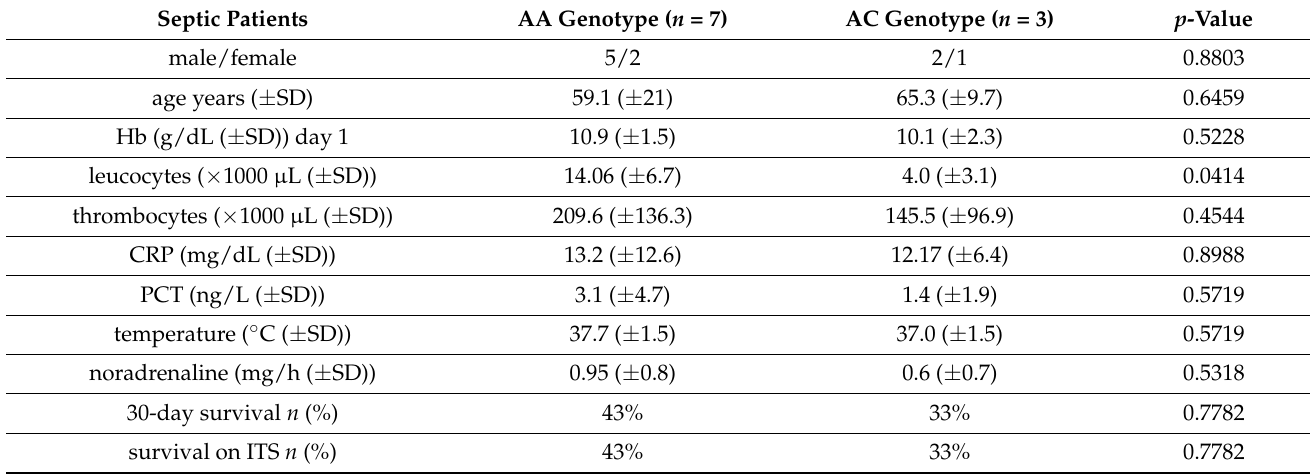
Table 1. Baseline characteristics of septic patients and healthy